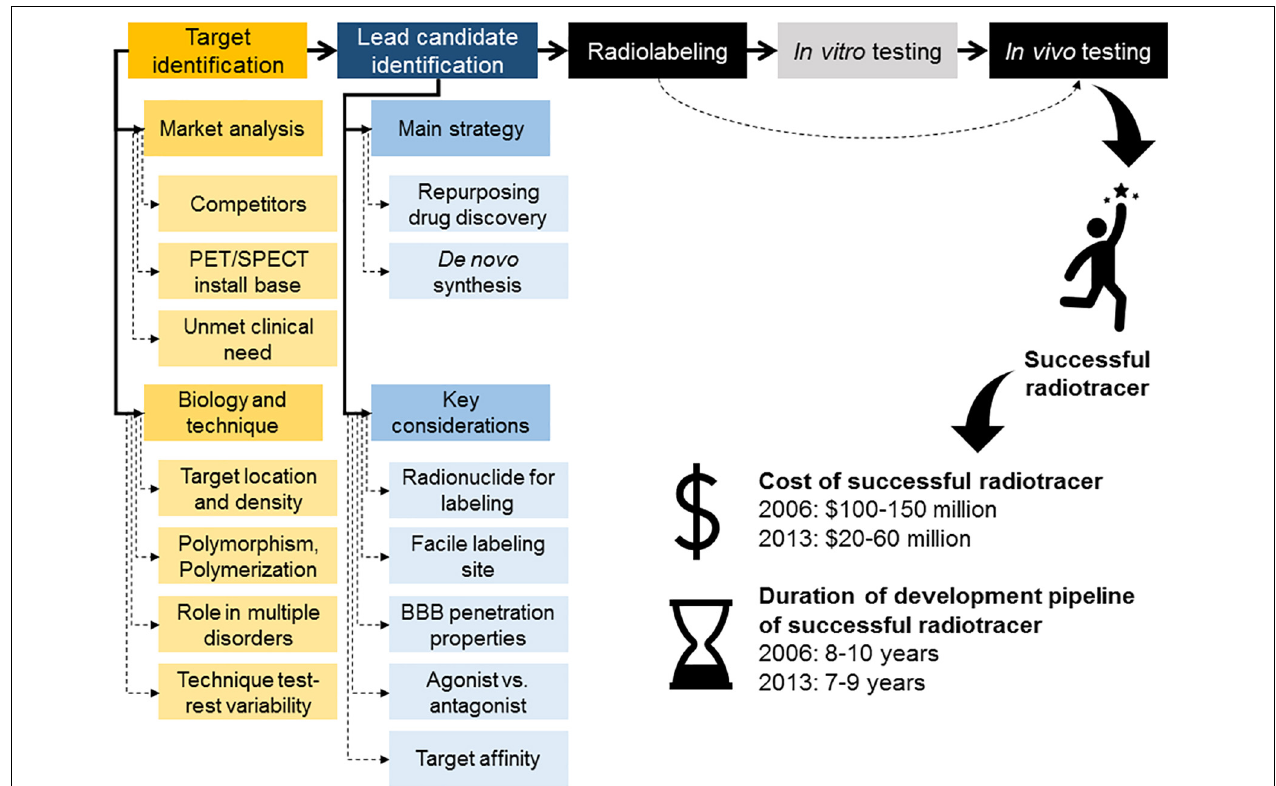
FIGURE 1 | Overview of radiotracer discovery and development pipeline. Main steps in the radiotracer discovery and development pipeline, including typical development costs and timelines for development of a successful radiotracer. A strategy to accelerate the process of radiotracer development involves removal of the in vitro testing of the radiolabeled compound and instead progress with the radiolabeled compound straight into in vivo